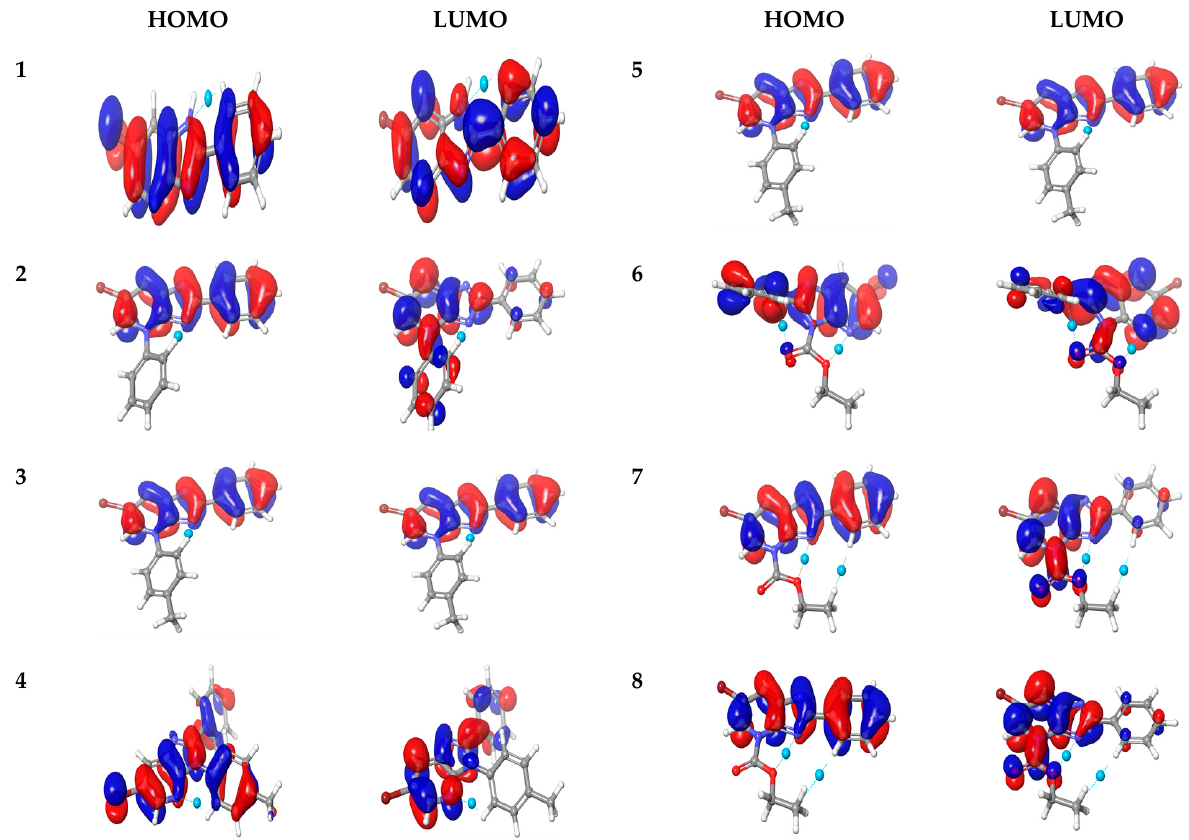
Figure 8. HOMO and LUMO orbitals for phenyl-3H-imidazo[4,5-b]pyridine derivatives that were simulated by TD-DFT/B 3 LYP/6-311G** using 0.032.